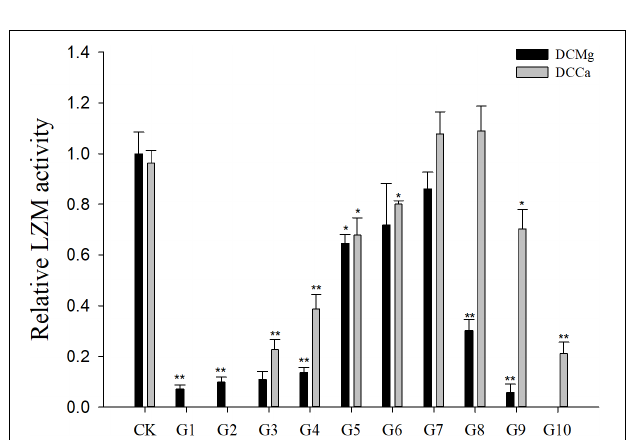
FIGURE 5 | Relative SOD activity of JSCs under long-term stress with different Ca 2 + and Mg 2 + concentrations. Results show SOD activity at 30-days normalized to the 0-day. Bars (mean ± SE, n = 3) with an asterisk denote a significant difference ( ∗ P < 0.05, ∗∗ P < 0.001) between the test groups (G1–G10) and CK.